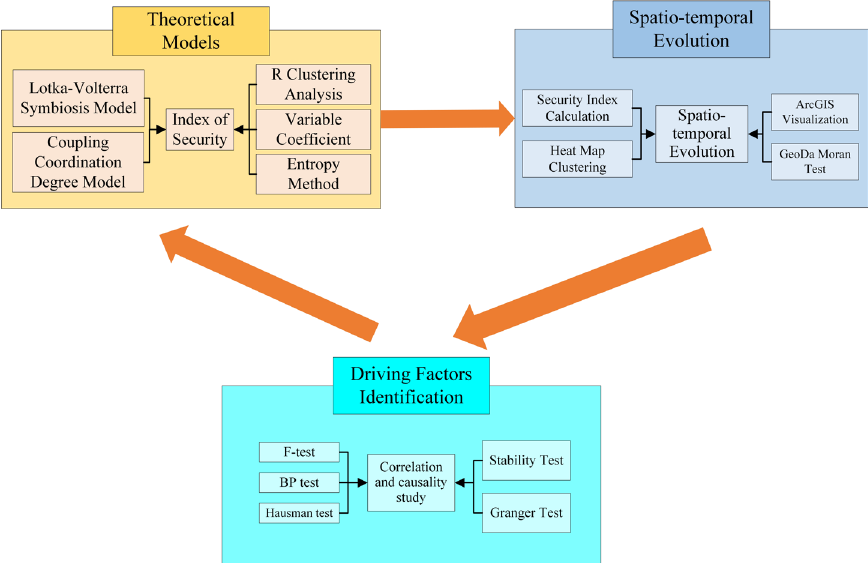
Figure 1. The research route of technology.